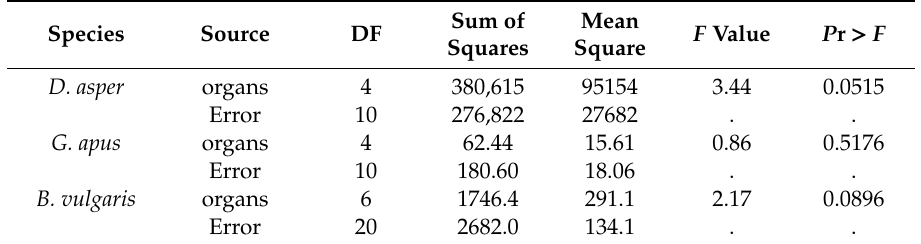
Table A3. Testing result of the homogeneity of variance among the deuterium signature ( δ D, % (cid:24) ) in di ff erent organs of B. vulgaris , G. apus , and D. asper where culms had been labeled 40 days earlier: signature in rhizomes, from di ff erent culm lengths, and from branches and leaves. The bamboos were cut down for the experiment. ‘ P > 0.05 ( P r > F )’ indicate equal variance among species.